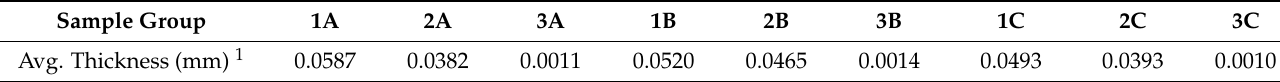
Table 4. Values of the average recast layer